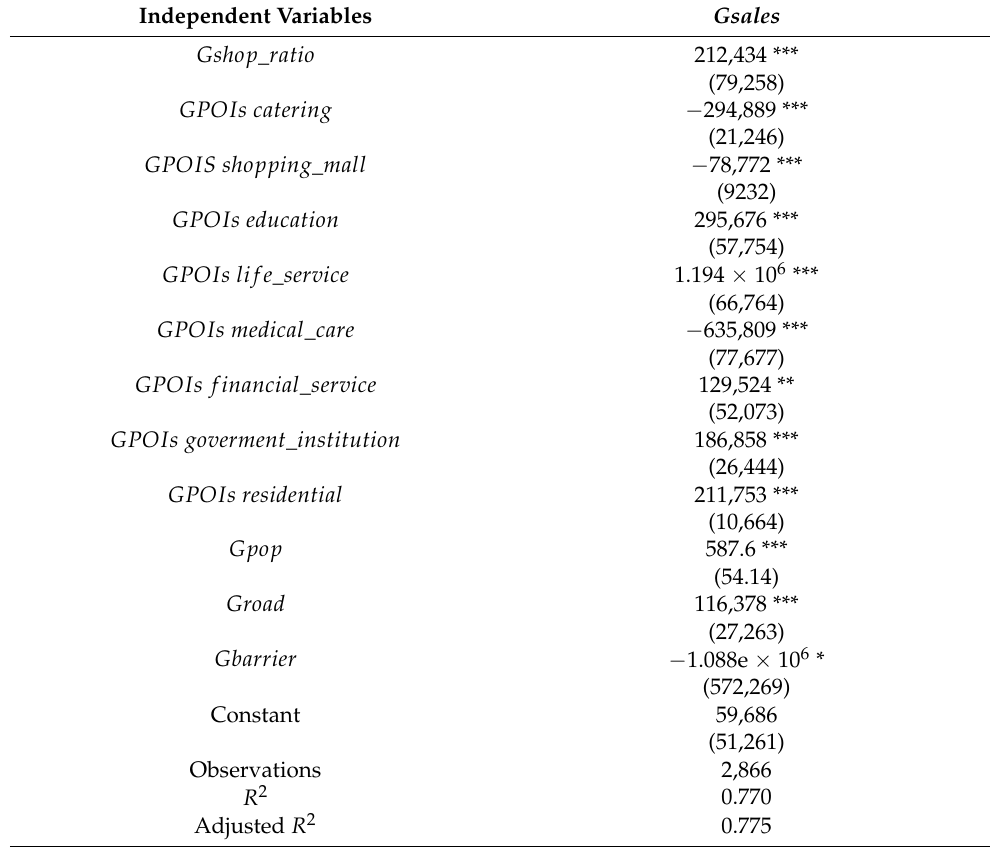
Table 3. Regression results of socioeconomic indexes and shop ratio on sales